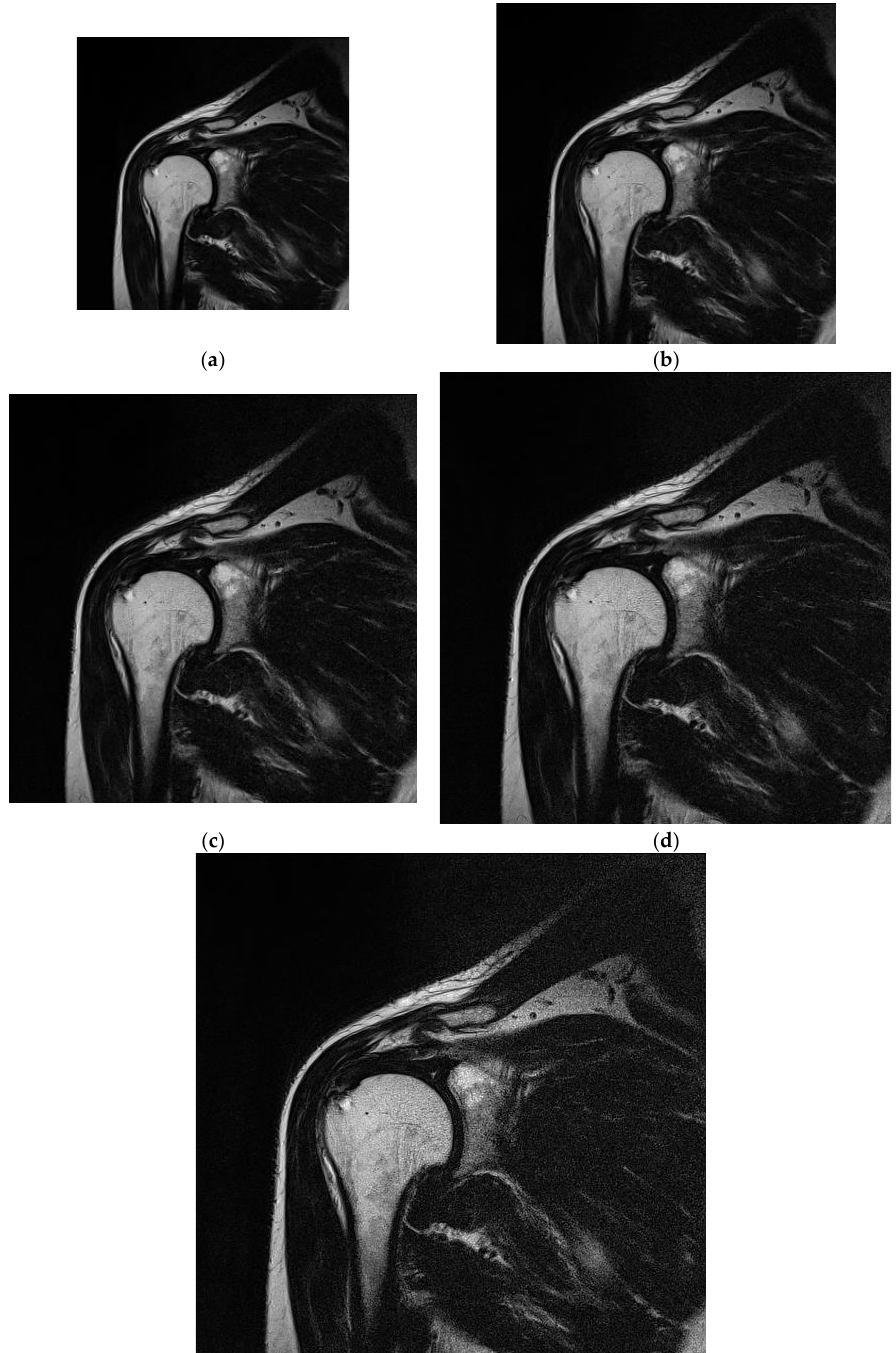
Figure 4. Sample analyzed images acquired for matrices with various sizes under the same FOV. ( a ) 256 × 256; ( b ) 320 × 320; ( c ) 384 × 384; ( d ) 448 × 448; ( e ) 512 × 512.